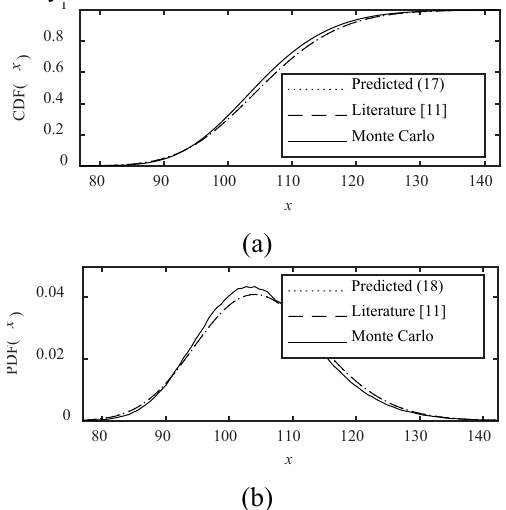
Fig. 4. Predicted CDF and PDF graph of largest eigenvalue